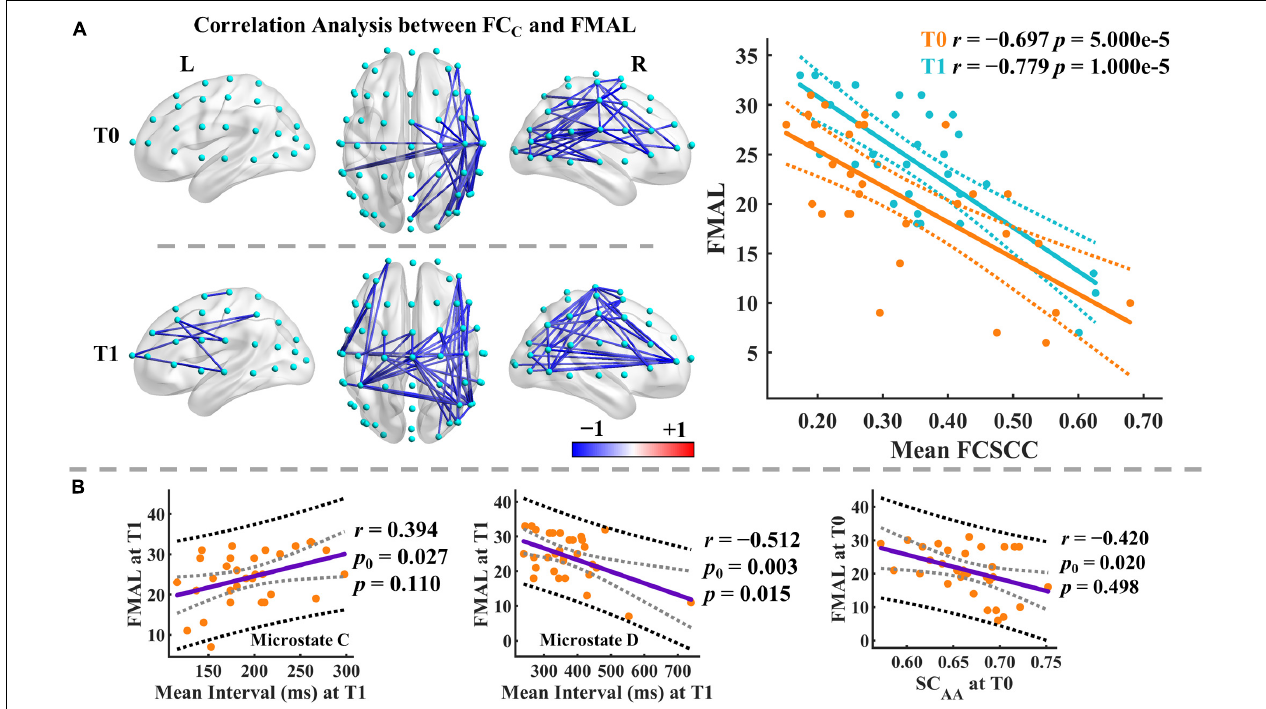
FIGURE 7 | Results of correlation analysis. (A) Correlation analysis between the functional connectivity of microstate C and FMAL score. Only the significant connected components are displayed. Mean FCSCC refers to the mean of the functional connectivity strength within the significant connected component. The blue color indicates negative correlations between the connectivity of microstate C and the FMAL score. Color depth represents the size of the correlation coefficient. Dashed lines imply the 95% confidence intervals for the regression estimates. Pearson correlation coefficient ( r ) and the corresponding permutation-based p -value are given. (B) Correlation analysis between microstate parameters and FMAL score. The black and gray dashed lines indicate the 95% prediction and 95% confidence intervals, respectively. Pearson correlation coefficient ( r ) and the corresponding permutation-based p -value are given. p 0 is the uncorrected p